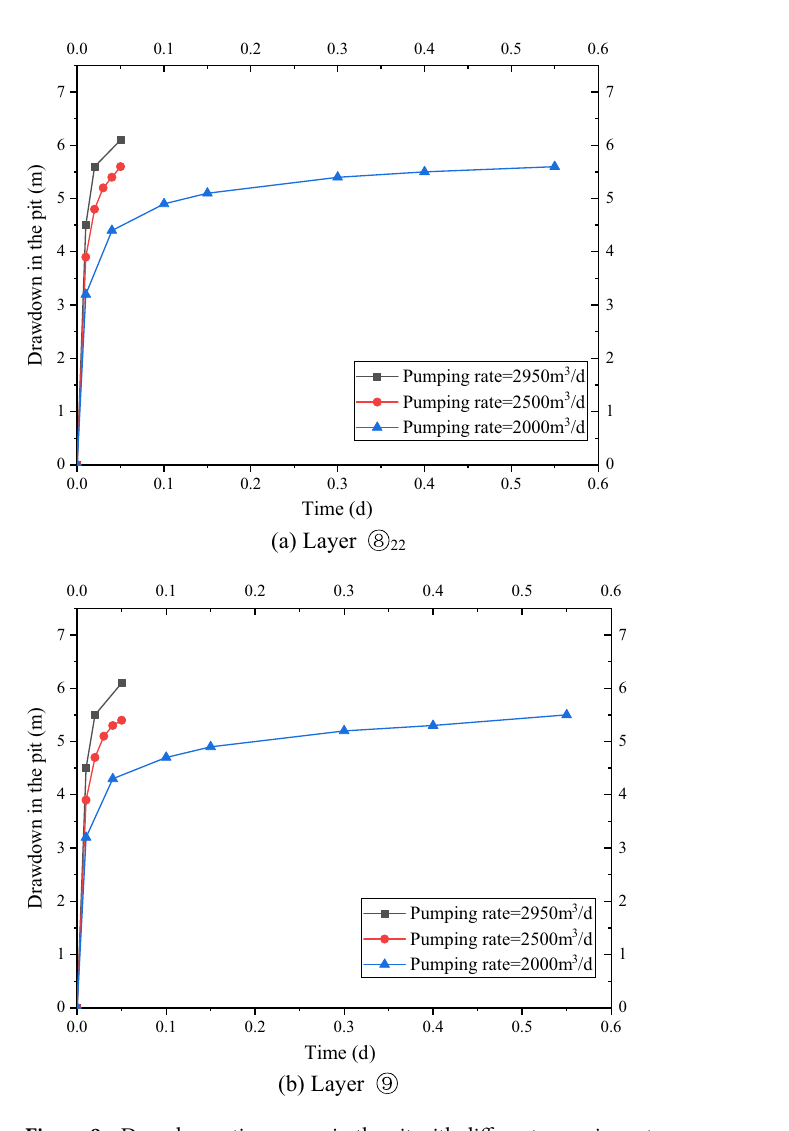
Figure 9. Drawdown–time curve in the pit with different pumping